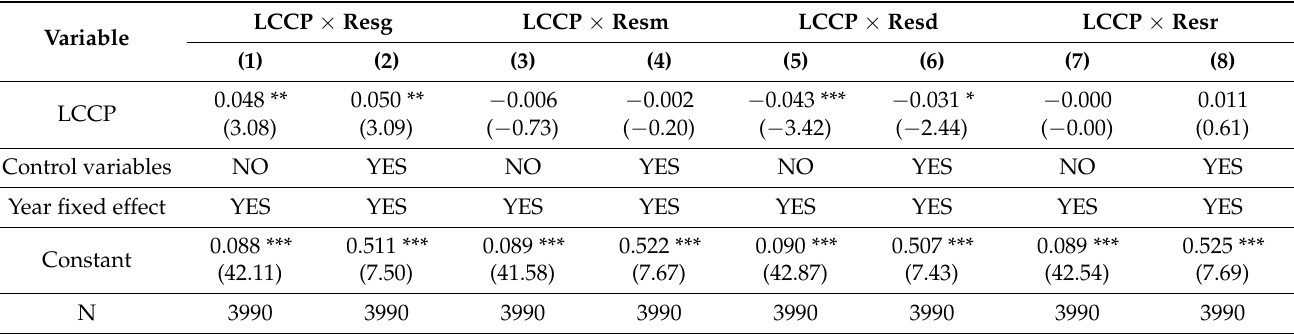
Table 6. Resource endowment heterogeneity test